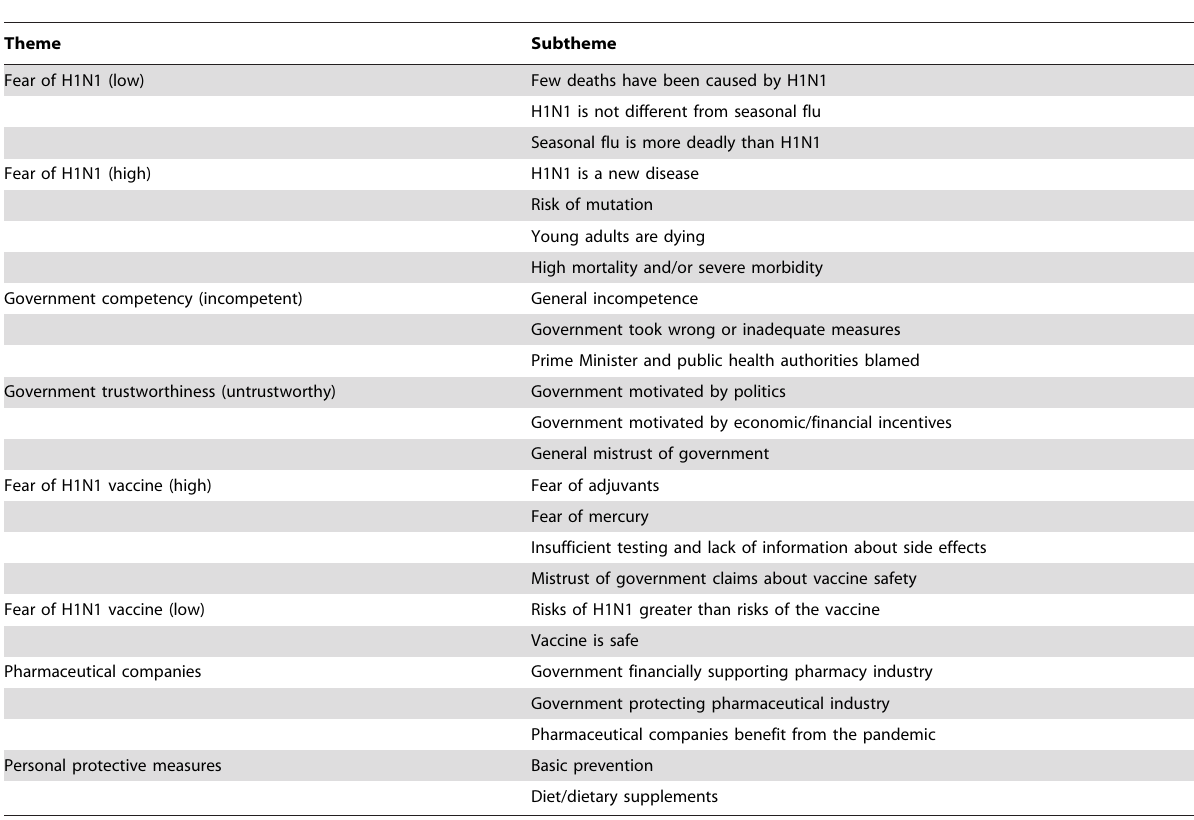
Table 4. Subthemes for themes mentioned in at least 5% of